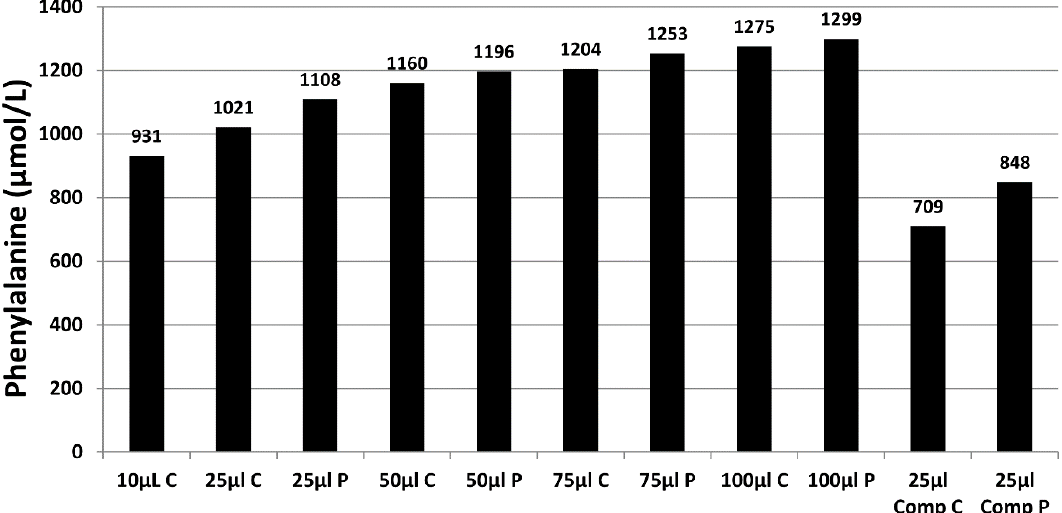
Figure 3. Effect of sample volume, punch location and compression of the sample on DBS phenylalanine concentrations in a patient with phenylketonuria (PKU) (results are a mean of n = 3). C, central punch; P, peripheral punch; Comp, compressed.